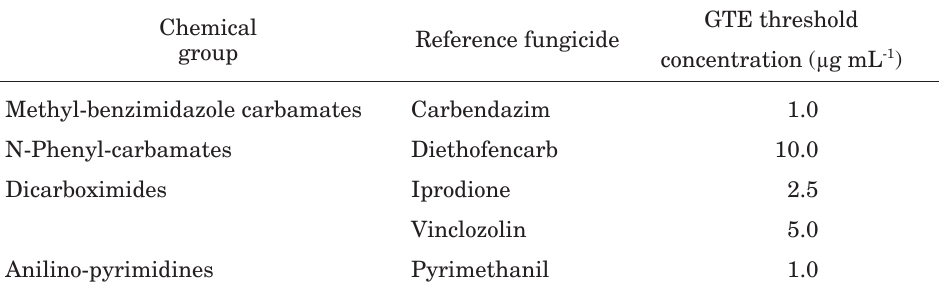
Table 2. Fungicides and threshold concentrations used for discriminating sensitive from resistant isolates in a germ tube elongation (GTE)